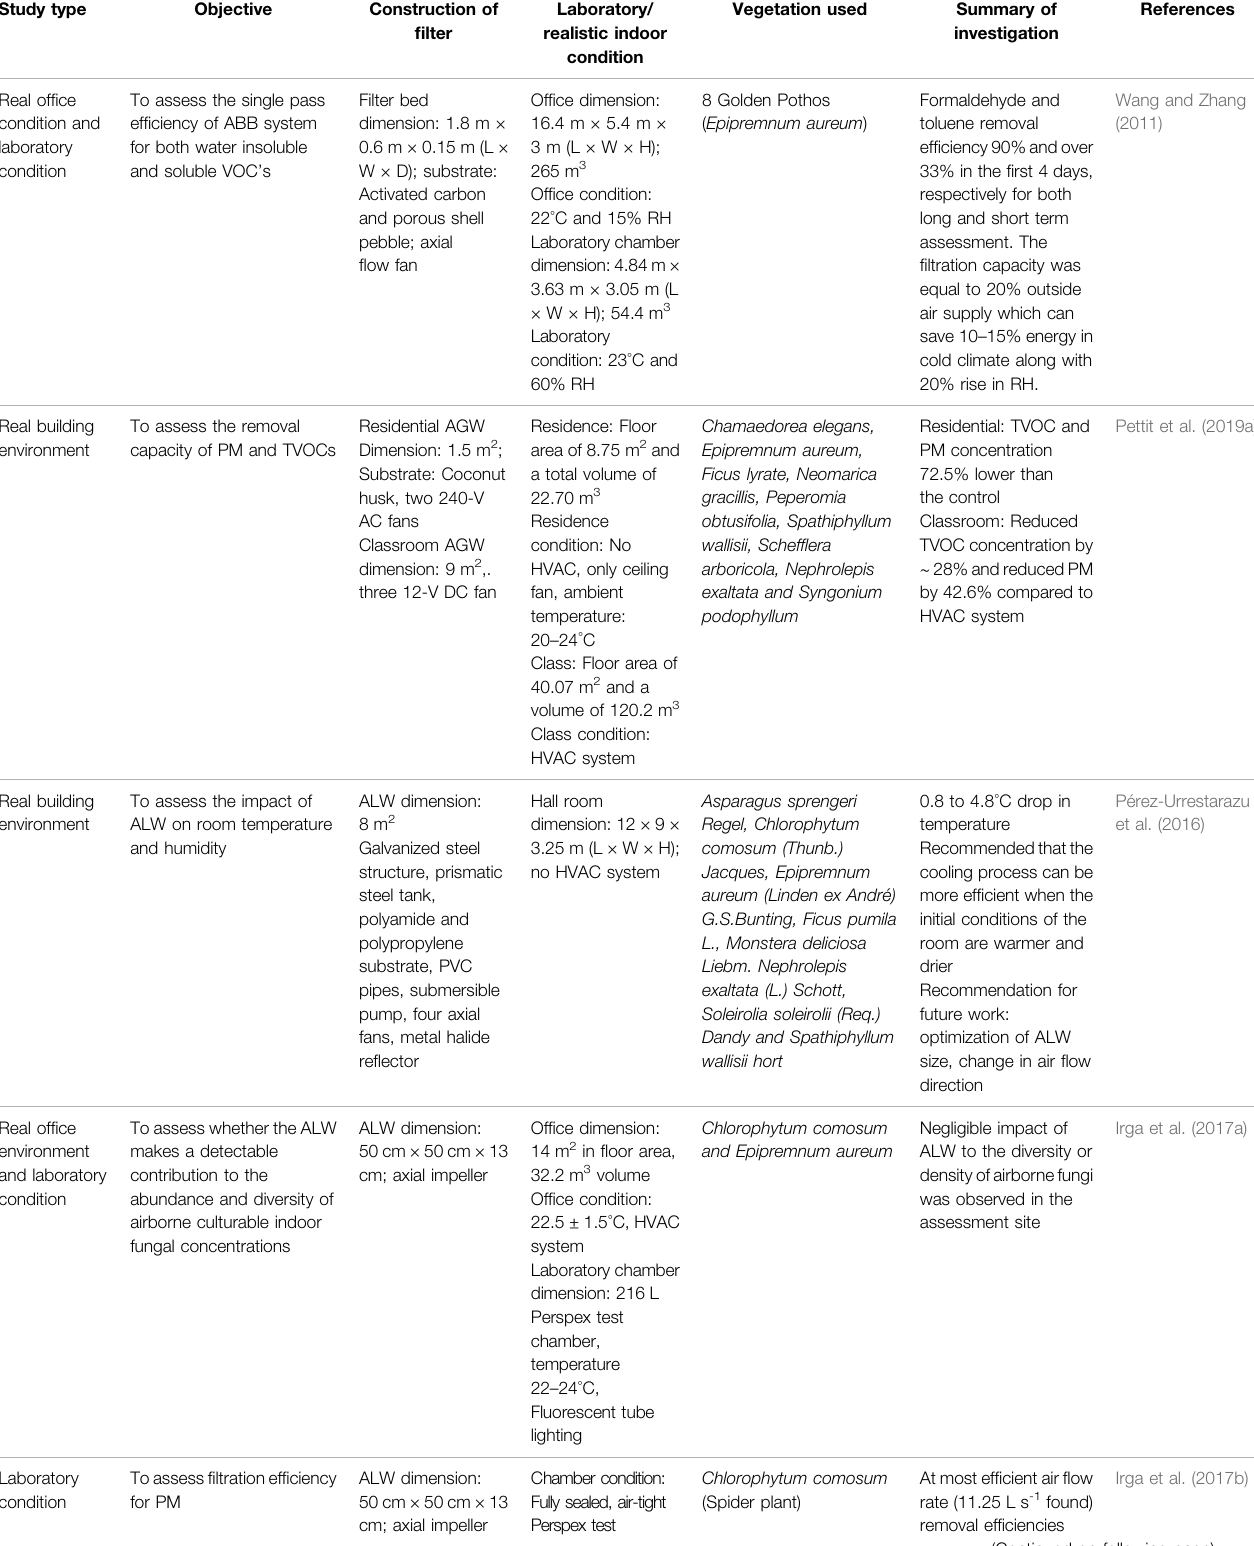
TABLE 1 | Summary of ALW systems. Analysis of the ALW/ABB studies performed in real and laboratory environment based on construction and operation conditions and pollutant removal